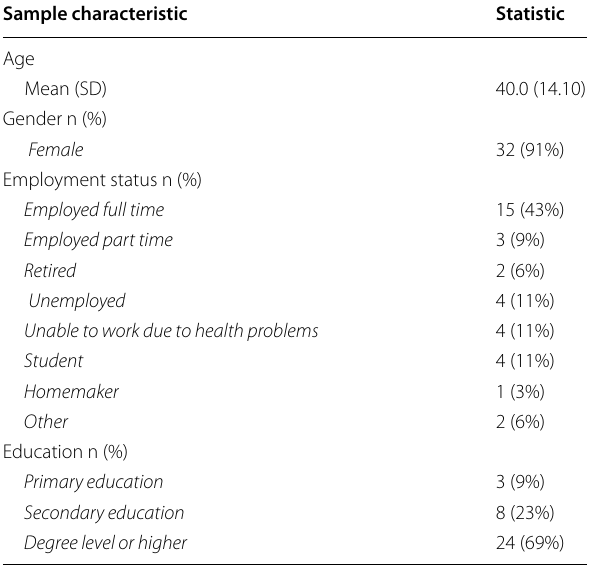
Table 1 Study sample socio-demographic characteristics ( n